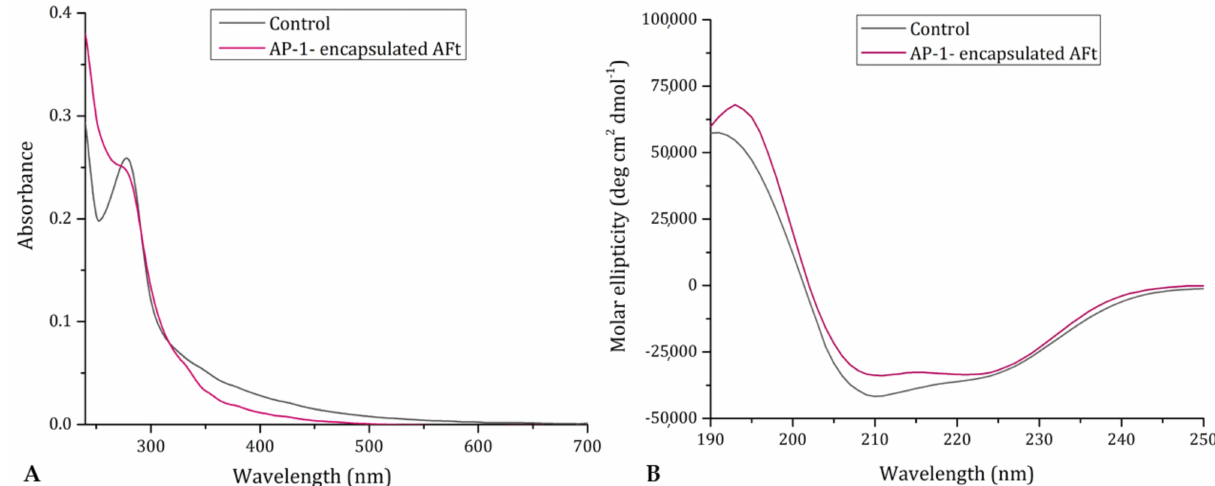
Figure 3. ( A ) UV–vis spectra of AP-1-encapsulated AFt (violet line) and of AFt used as control (control, black line). ( B ) Far-UV CD spectra of AFt (control, black line) and AP-1-encapsulated AFt (violet